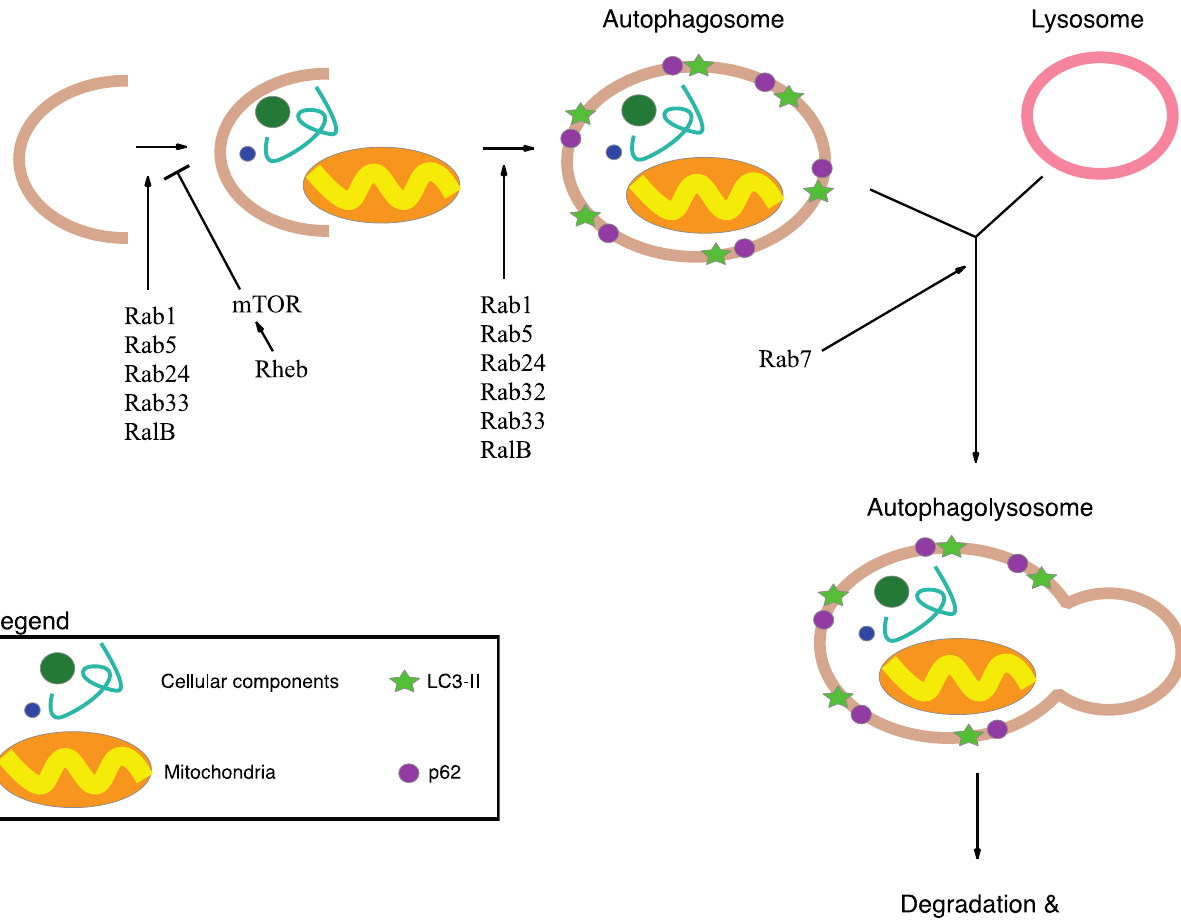
Figure 2. Schematic representation of macroautophagy mechanism and its main actors. Macroautophagy delivers cellular components and damaged or redundant organelles (such as mitochondria), to the lysosome through the intermediary of a double membrane-bound vesicle, referred to as an autophagosome. Autophagy is initiated by the formation of the isolation membrane that induces the formation of autophagosome. Subsequently, the autophagosome fuses with the lysosome to form an autolysosome. Finally all the material is degraded in the autophagolysosome and recycled. The p62 protein interacts with damaged proteins in the cells, and the complexes are then selectively tied to the autophagosome through LC3-II. Rabs, Rheb and RalB are autophagy-related protein important for the regulation of macroautophagy